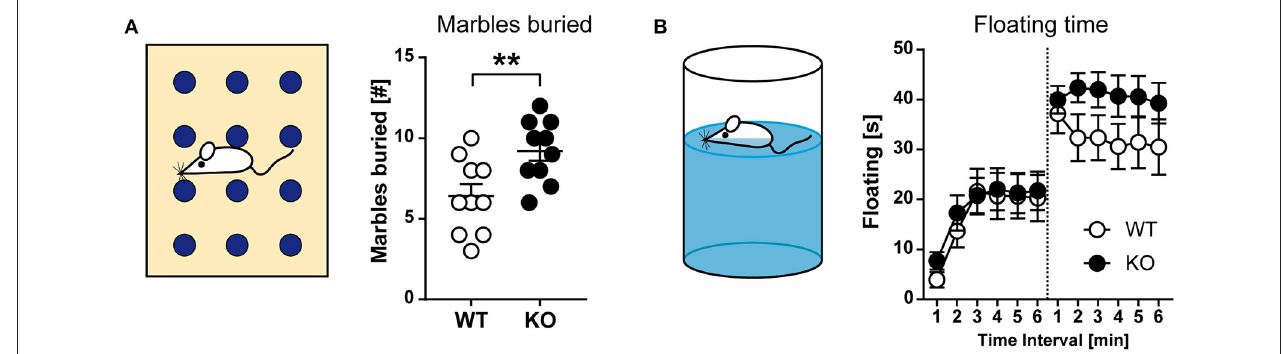
FIGURE 6 | Behavioral characterization of HCN3 − / − mice (part 2). (A) Marble burying test. Schematic of the testing environment (left), where mice exposed to a cage containing 12 identical glass marbles. HCN3 − / − mice buried more marbles as compared to wild type littermates during a 30min exposure time period (right). (B) Forced swimming test. Schematic of the testing environment (left). Mice are placed in an inescapable cylinder filled with water and the time spent floating (immobile) is measured. Mice were exposed to the forced swim test for 6min on two consecutive days. HCN3 − / − animals tended to spend more time floating on the second testing day (right). All values are Mean ± SEM, ** p <